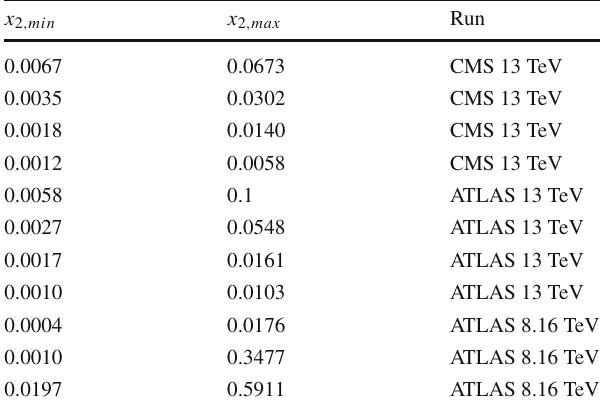
Table 1 Extreme values of x 2 probed within the kinematic regions of the CMS and ATLAS detectors in both pp and p A collisions at